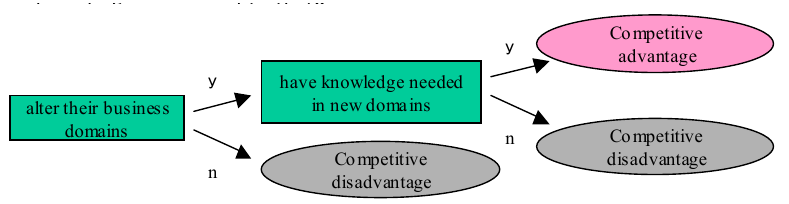
Figure 4. When the product or process architecture changes, how do firms respond to